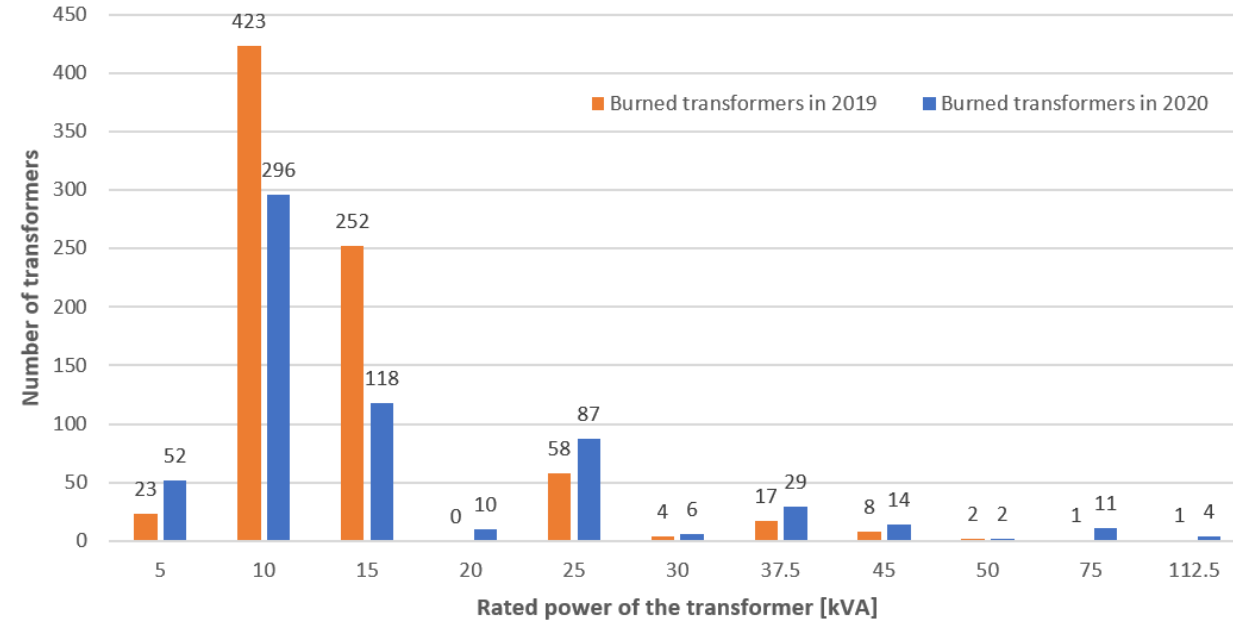
Figure 5. Transformer data and number of burned transformers for 2019 and 2020.